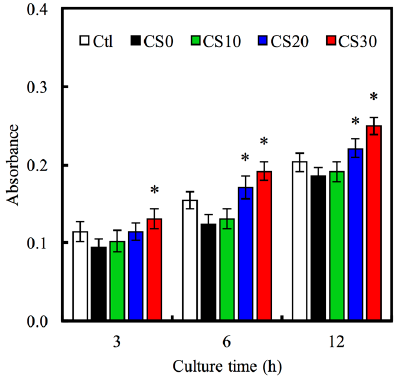
Figure 7. The adhesion of hMSCs cultured with various specimens for different time-points. “*” indicates a significant difference ( p < 0.05) compared to CS0.